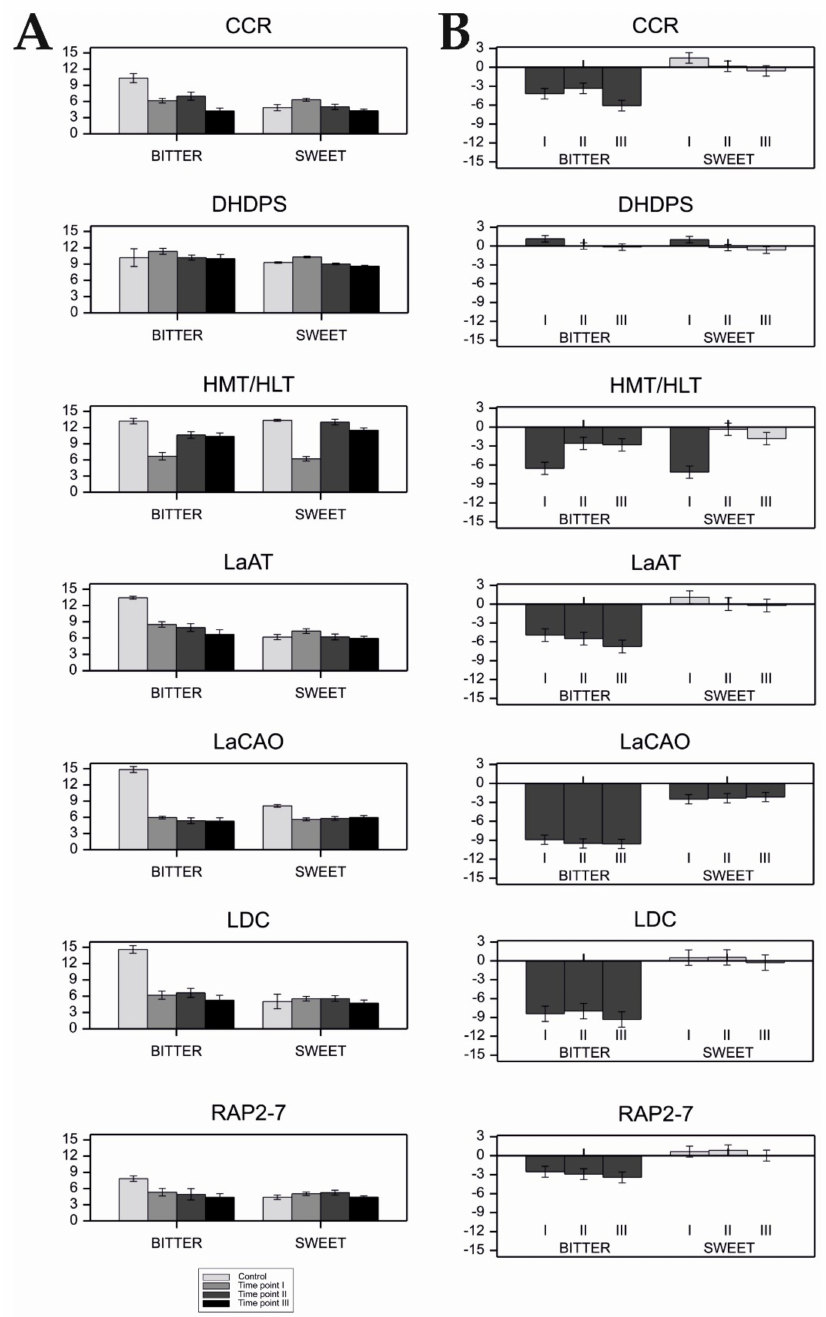
Figure 5. Expression patterns of alkaloid (QA) genes measured during Colletotrichum lupini infection in two groups of narrow-leafed lupin cultivars with contrasting seed alkaloid content. Plants with high alkaloid content are referred to as ‘bitter’ (two cultivars) and plants with low alkaloid content are referred to as ‘sweet’ (six cultivars). Full names of genes are listed in Table 1. ( A ) QA gene expression measured in control plants and at three time-points during Colletotrichum lupini infection (48 h, 72 h, and 120 h after inoculation). Log 2 -transformed mean values and standard errors are depicted. ( B ) FC values for QA gene expression at consecutive time-points of infection (I–III) in comparison to the control. Dark grey bars indicate statistically different expression ( p < 0.05). Bars above the x-axis represent increased expression and those below the x-axis represent decreased expression after infection. FC of expression is shown in log 2